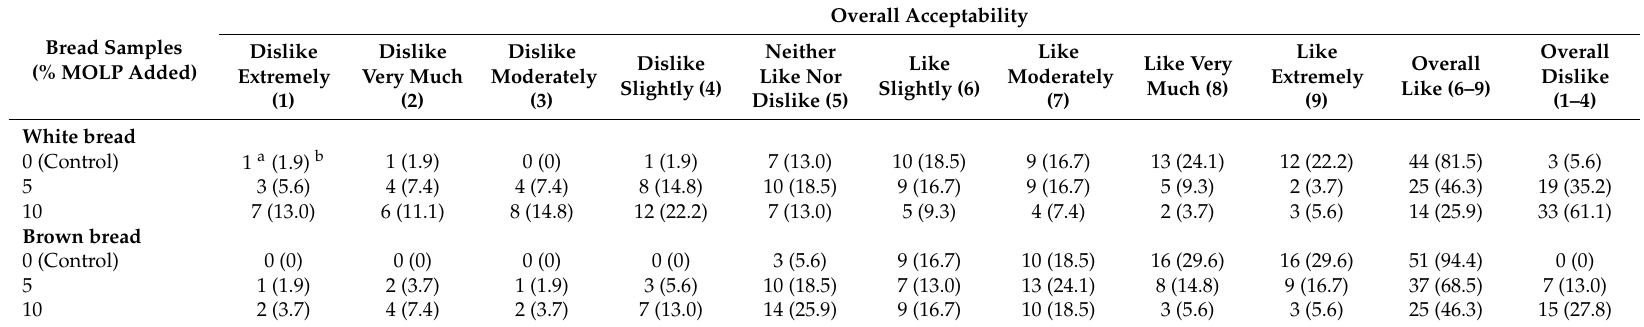
Table 6. The e ff ect of Moringa oleifera leaf powder (MOLP) on the overall acceptability of white and brown breads as shown by percentage distribution of sensory evaluation